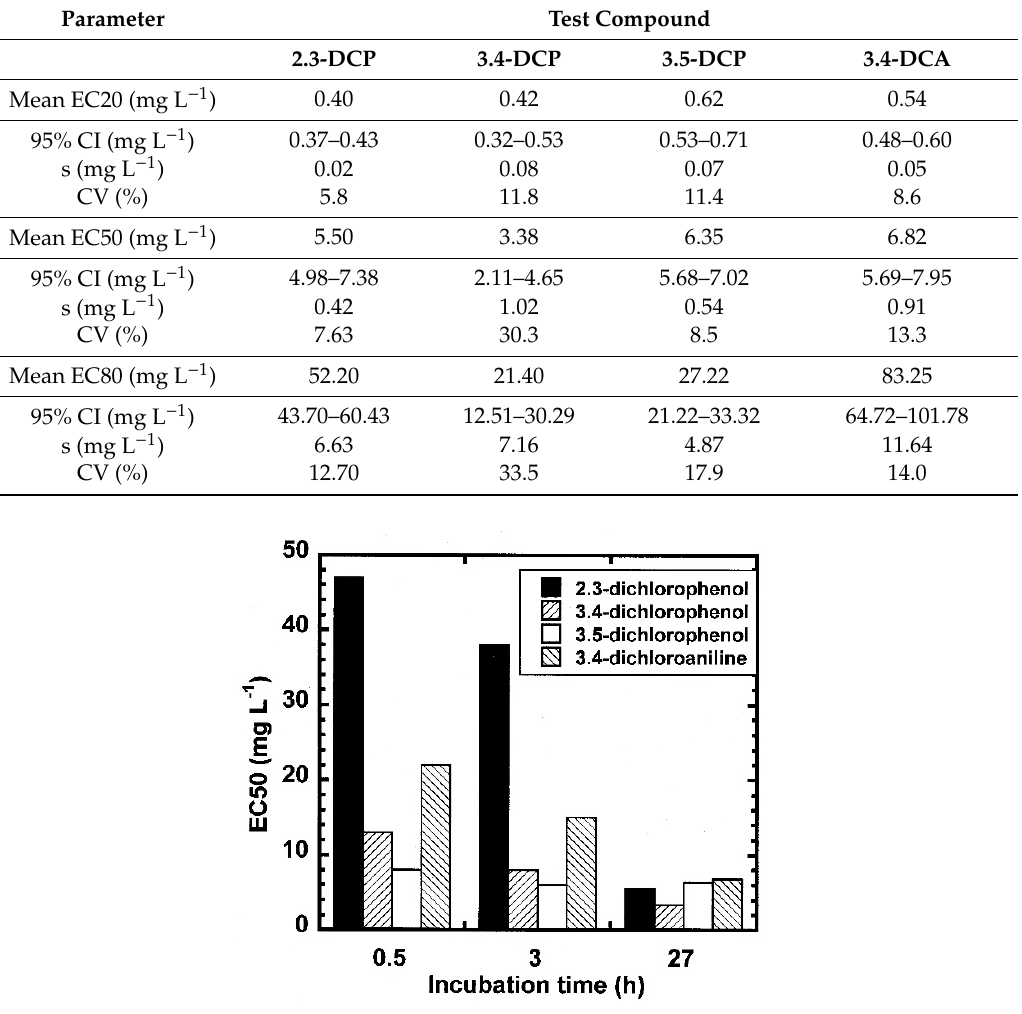
Figure 8. EC50 values for several dichlorophenols and 3.4-dichloroaniline, obtained in the respiration inhibition test at different incubation times.